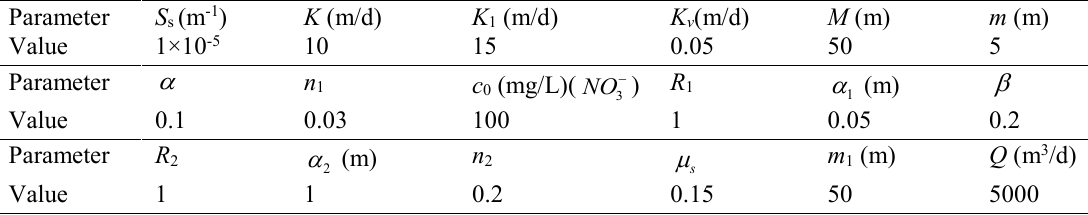
Table 1 Parameter values used in the groundwater flow and transport model.